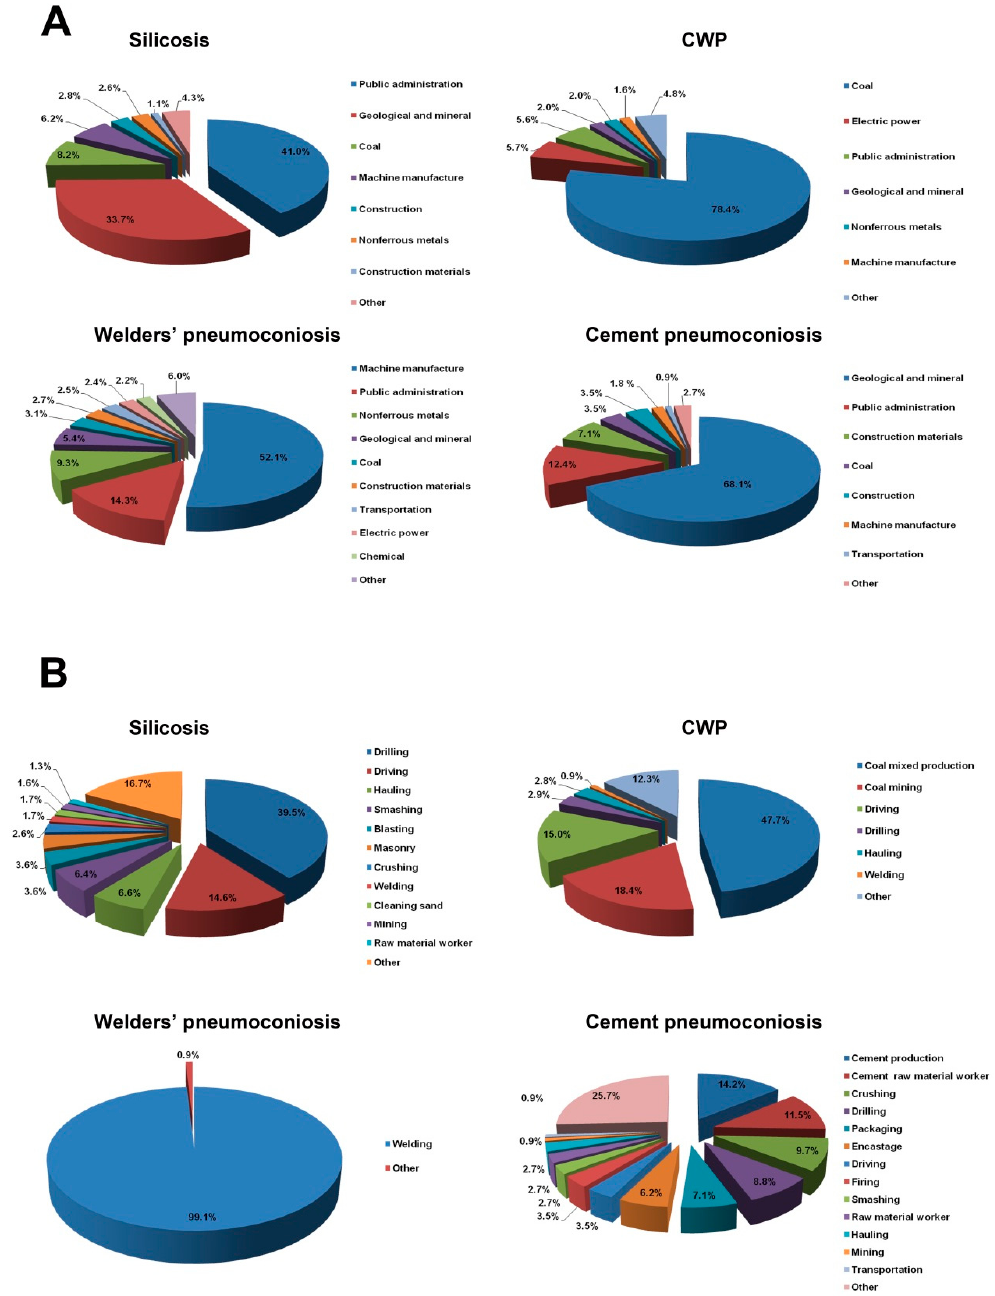
Figure 4. The industry and occupation distribution of pneumoconiosis cases reported from 2006 to 2017. ( A ) Industry distribution in different types of pneumoconiosis cases. ( B ) Occupation distribution in different types of pneumoconiosis cases.